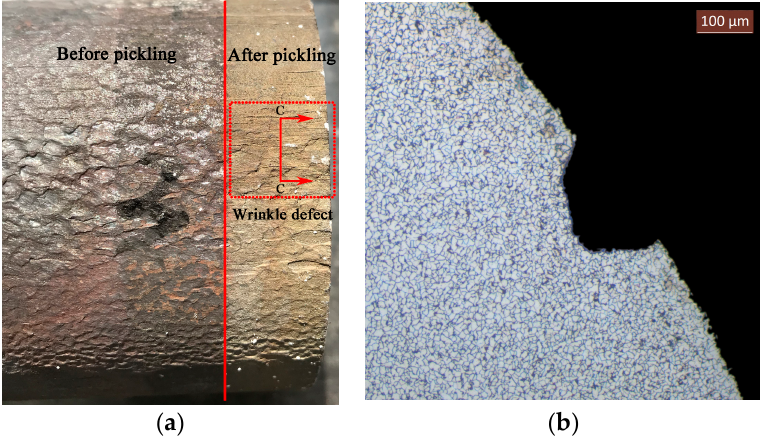
Figure 1. Morphological features of surface wrinkle defect. ( a ) Front view. ( b ) Cross-section view C-C. Currently, high quality products are demanded due to increasingly fierce market competition